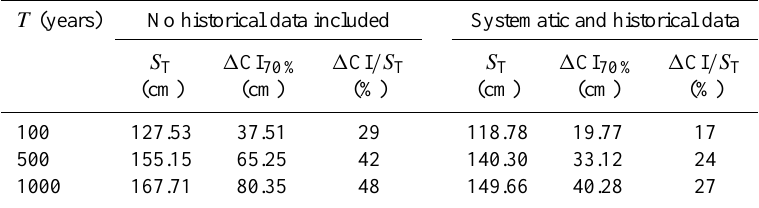
Table 3. The T -year quantiles (in cm) estimated on the basis of the systematic and historical periods and absolute and relative widths of their 70% confidence intervals (the POTH frequency